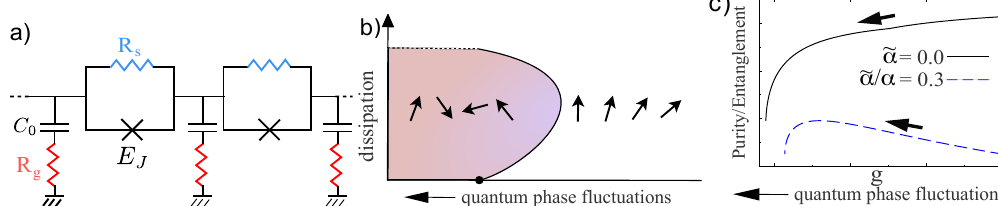
Figure 1. ( a ) 1D chain of superconducting islands with Josephson coupling of energy E J and a capacity to the ground C 0 . The shunt resistance R s corresponds to a dissipative coupling for the difference of the superconducting phases ϕ n , whereas the resistance to the ground R g yields a dissipative coupling in the charge Q n . ( b ) Qualitative quantum phase diagram with dissipative frustration. ( c ) Qualitative results for the purity and the logarithmic negativity as function of the parameter g for conventional dissipation (solid line) and frustrated dissipation (dashed